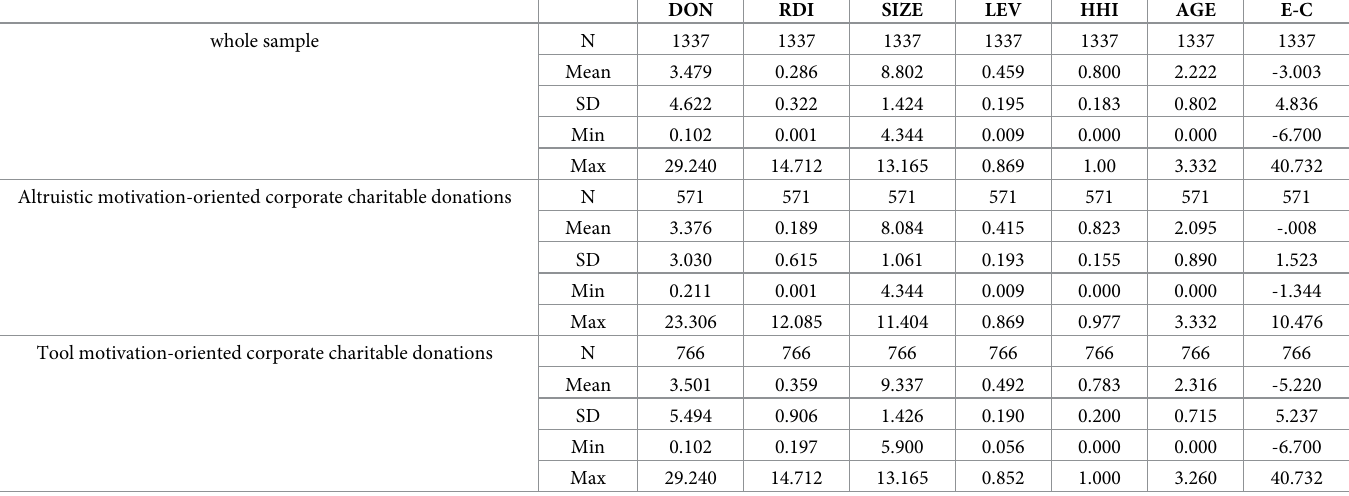
Table 3. Descriptive statistics of continuous